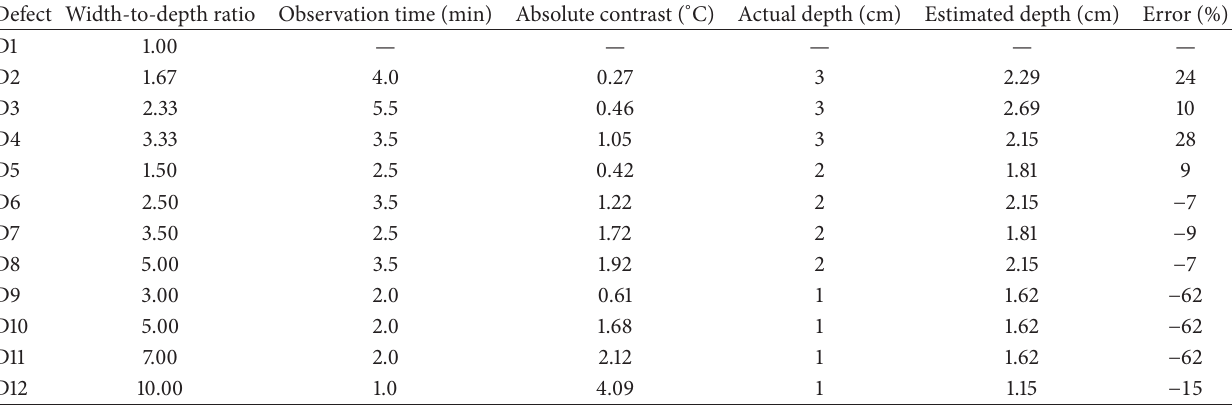
Table 6: Results of detecting the depth of the defects for the 20-minute heating cycle.